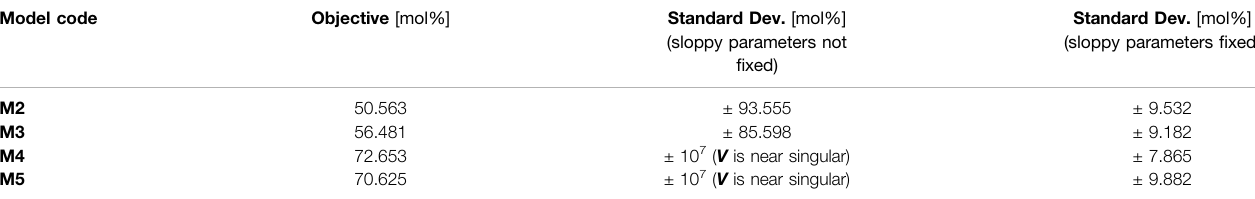
TABLE 3 | Comparison of the effect of parametric uncertainty in models M2 to M5 on optimal conversion predictions to butene and heavier ole fi ns. The Objective column lists the value of the optimization problem objective function. The following two columns list the standard deviation in predicted objective function values due to parametric uncertainties associated with the ROK models with sloppy parameters not fi xed and sloppy parameters fi xed, respectively. Model